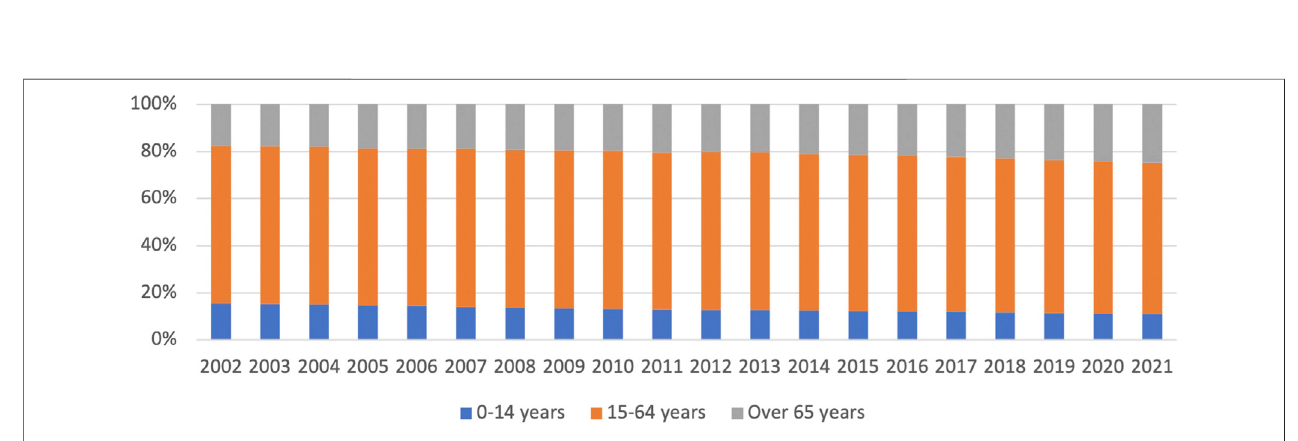
FIGURE 2 | Age structure of the population in Noci (% values) - Source: Istat — 1st January 2019.